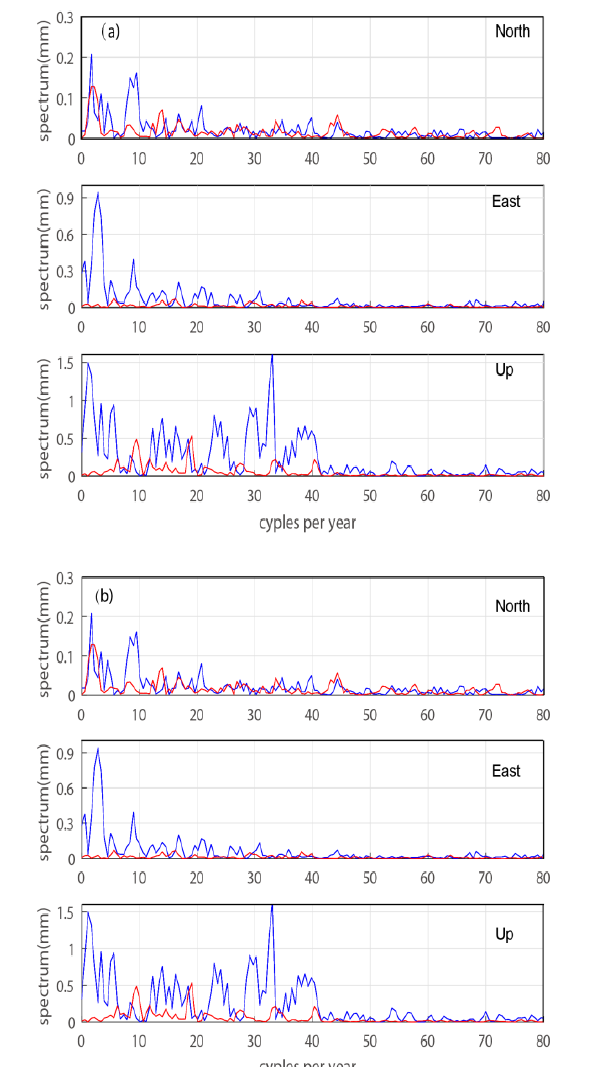
Figure 4 . Comparison of CME principal component Spectral analysis considering amplitude Modulation and constant amplitude. Horizontal axis: cycles per year, Blue: constant amplitude, Red: Consider amplitude modulation. (a), the first principal component (b) the second principal